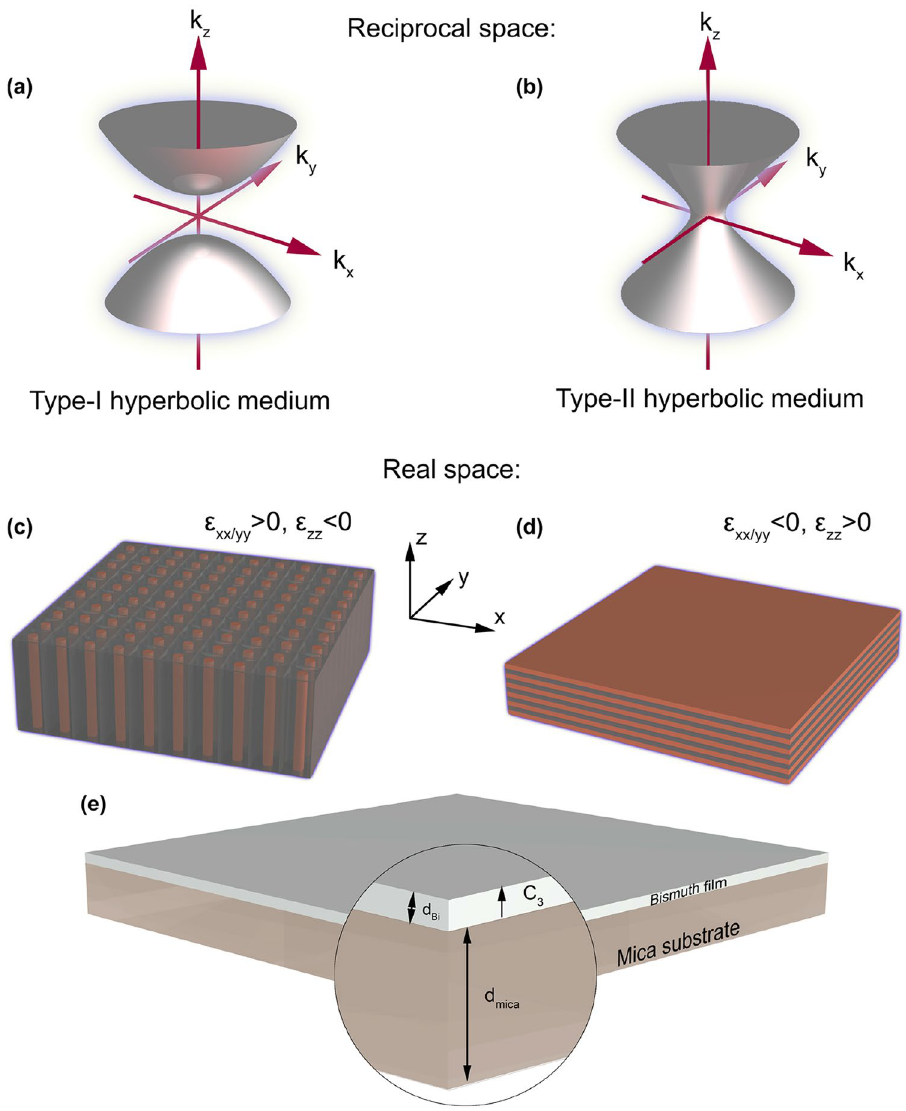
Figure 1. Isofrequency surfaces in reciprocal space (k-space) for I ( a ) and II ( b ) types of hyperbolic media and corresponding typical structural geometries ( c,d ). ( e ) The scheme of a layered structure proposed in this work (not in scale). The C 3 axis of a bismuth film is oriented normally to its